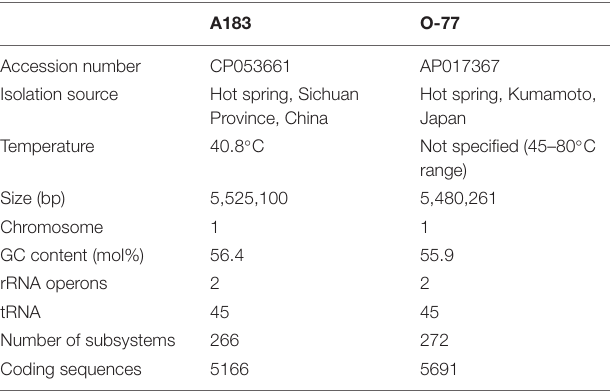
TABLE 3 | Genome features of Thermoleptolyngbya strains A183 and